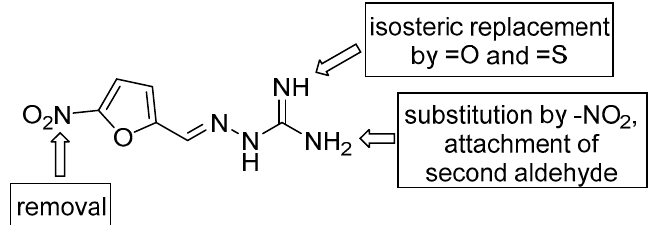
Figure 2. Design of 5-nitrofuran-based aminoguanidine analogues of 1n .